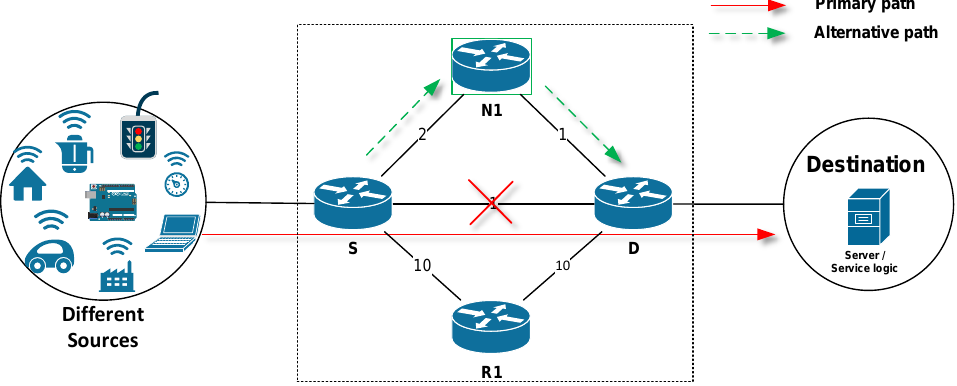
Figure 1. IP Fast Reroute (FRR) technology. S, source router; N1 (1 — index of router), alternative next-hop router; D, destination router; R1, router 1 not actively involved in FRR repair.